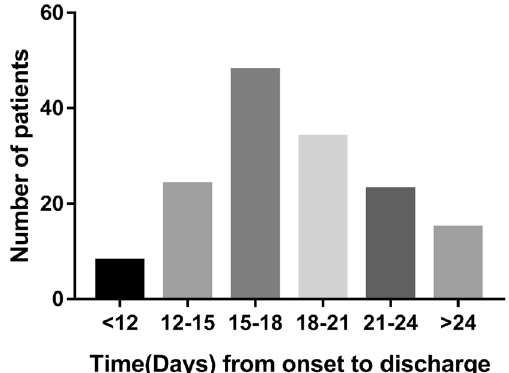
Figure 2. Hospitalization day and other time distributions for COVID-19 infected